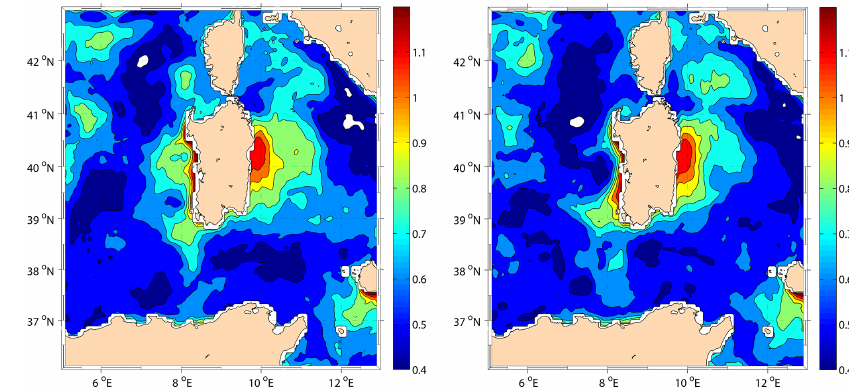
Figure 3. Map of SST RMSE (whole period) for BF (left) and BFC experiments. Units are ◦ C.